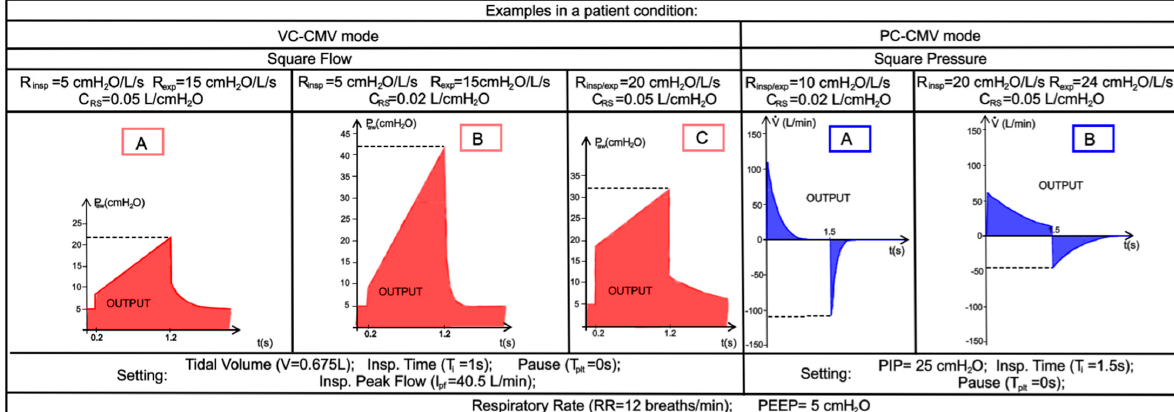
Figure 26. Case 3. Real − life trends of pressure (VC − CMV mode, in red) and flow (PC − CMV mode, in blue) concerning the inspiratory/expiratory resistance and lung compliance changes, adapted from [49]. VC − CMV mode ([A] C RS = 0.05 L/cmH 2 O, R insp = 5 cmH 2 O/L/s, R exp = 15 cmH 2 O/L/s; [B] C RS = 0.02 L/cmH 2 O, R insp = 5 cmH 2 O/L/s, R exp = 15 cmH 2 O/L/s; [C] C RS = 0.05 L/cmH 2 O, R insp/exp = 20 cmH 2 O/L/s); PC − CMV mode ([A] C RS = 0.02 L/cmH 2 O, R insp/exp = 10 cmH 2 O/L/s; [B] C RS = 0.05 L/cmH 2 O, R insp/exp = 20 cmH 2 O/L/s). The operating and geometrical parameters of the ventilator, shown in Table 4, are the same as those used in the previous simulations, while the independent, dependent, and patient variables are reported in Table 9.